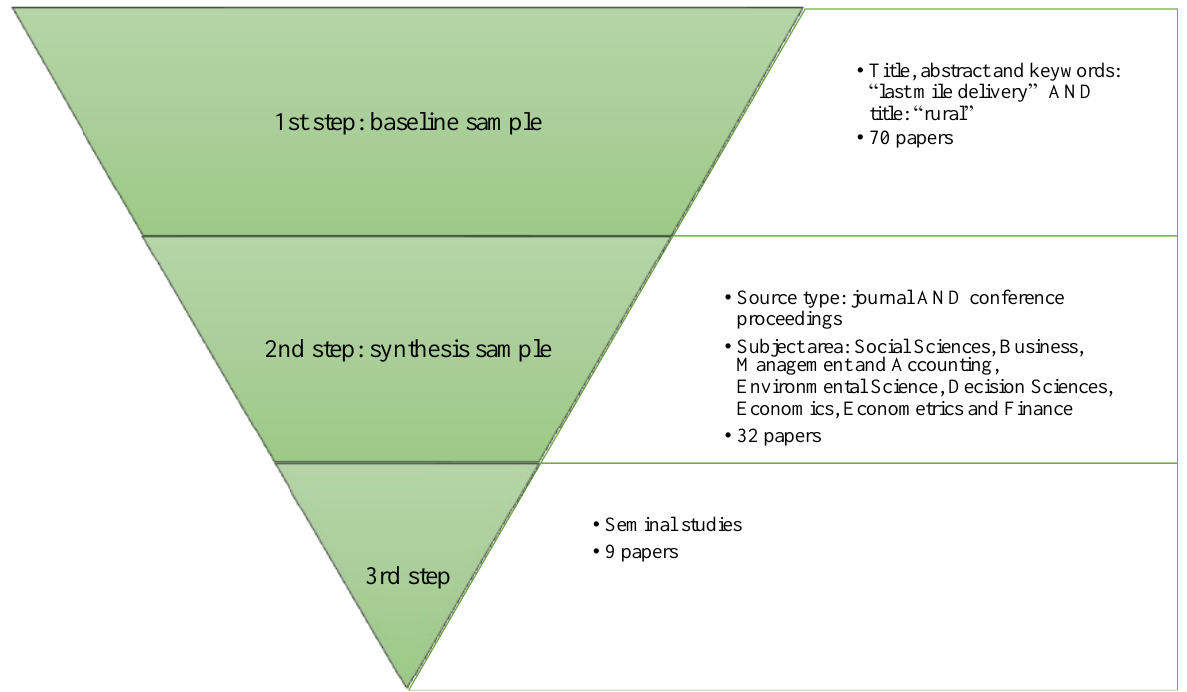
Figure 1. Procedure for systematic literature review from the Scopus database (own elaboration).